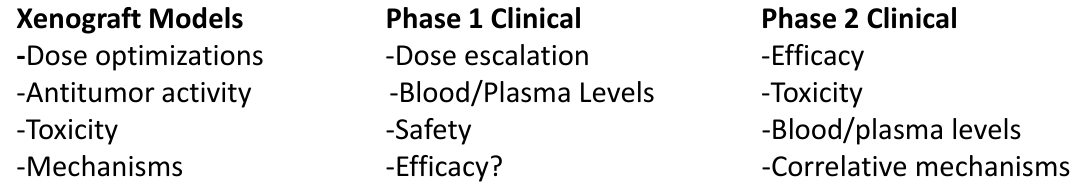
Chart 1. “Bench-to-bedside” therapeutic development of SLM from preclinical models to phase 1 and 2 clinical trials in patients with advanced clear-cell renal cell carcinoma